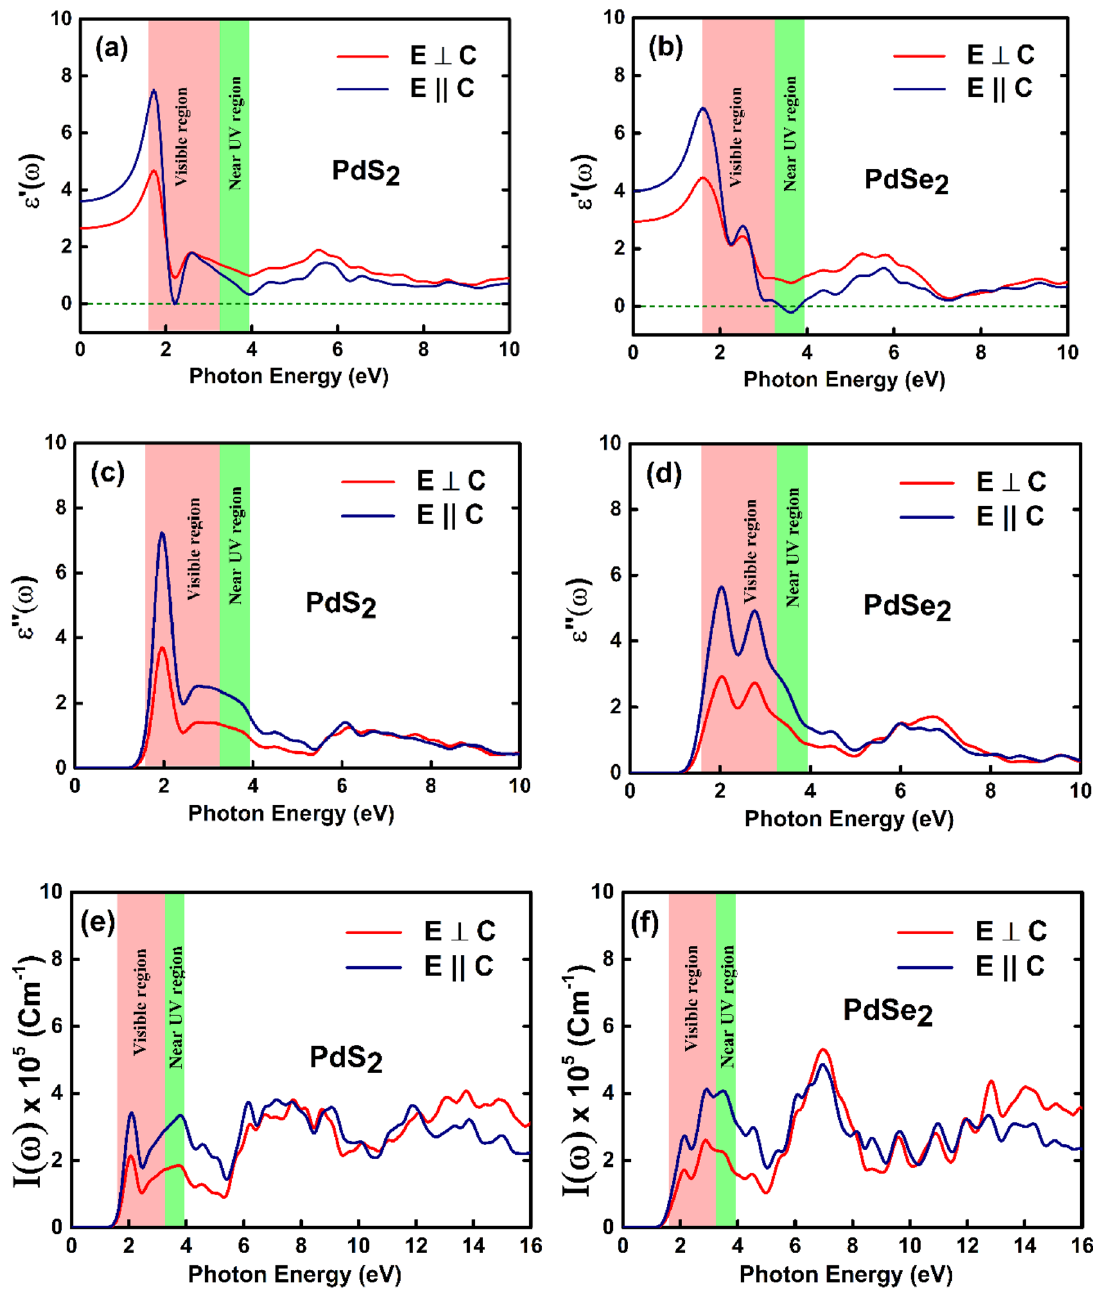
Figure 9. Computed optical properties of penta-PdQ 2 monolayers for parallel and perpendicular polarization ( a , b ) real ( ε ’) and ( c , d ) imaginary ( ε ”) parts of complex dielectric function. ( e , f ) absorption coefficient I (ω) about the electronic polarizability of the material from the Clausis—Mossotti 68 relation. It can be seen from the Fig. 9a,b, the static dielectric constant ( ε (cid:31) (0), ε ⊥ (0)) of penta-PdS 2 is (3.56, 2.62), while static dielectric constant of penta-PdSe 2 is 4.0 ( ε (cid:31) (0)) and 2.94 ( ε ⊥ (0)). This means that its ε (0) of parallel optical vector have more domi- nant polarizability compared to the perpendicular of ε (0). The optical peculiarity is strongly connected to the imaginary part of the dielectric function ε ”(ω), which reflects the transition between the energy bands near the E F levels and that would be govern the linear response of the material to light under small wave vector as depicted in Fig. 9 (c, d). Therefore, the imaginary part ε ”(ω) in case of penta-PdS 2 , the one major peak occurred at 1.98 eV in the visible ( VIS ) region for both ε ⊥ (ω) and ε || (ω) case as plotted in Fig. 9c. While, in case of penta-PdSe 2 , it is clearly seen (Fig. 9d) that there are two intense peaks appeared in the visible region ( VIS ) at ħω = 2.04 eV and 2.76 eV due to the electronic transition of ‘4p’ states of Se atom and ‘4d’ states of Pd atom between conduction bands (CBs) and valence bands (VBs) of the electronic band structure. Apparently, the peaks tendency of ε ⊥ (ω) and ε || (ω) are similar on the photon energy spectrum for both penta-PdQ 2 monolayers.